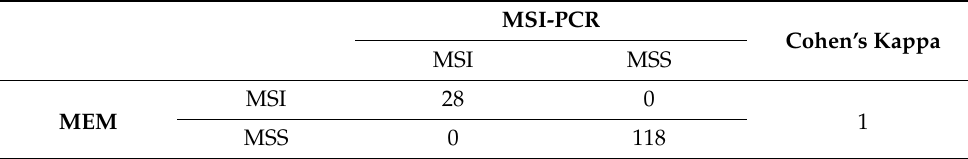
Table 1. Concordance between MSI-PCR results and MEM results for MSI